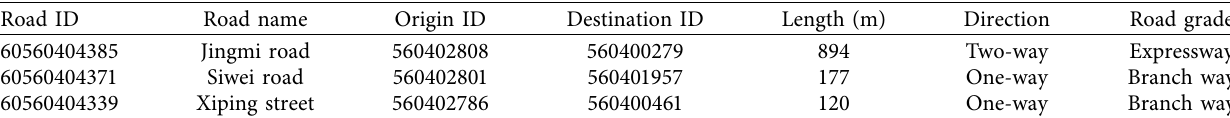
Table 2: Example of road vector data.